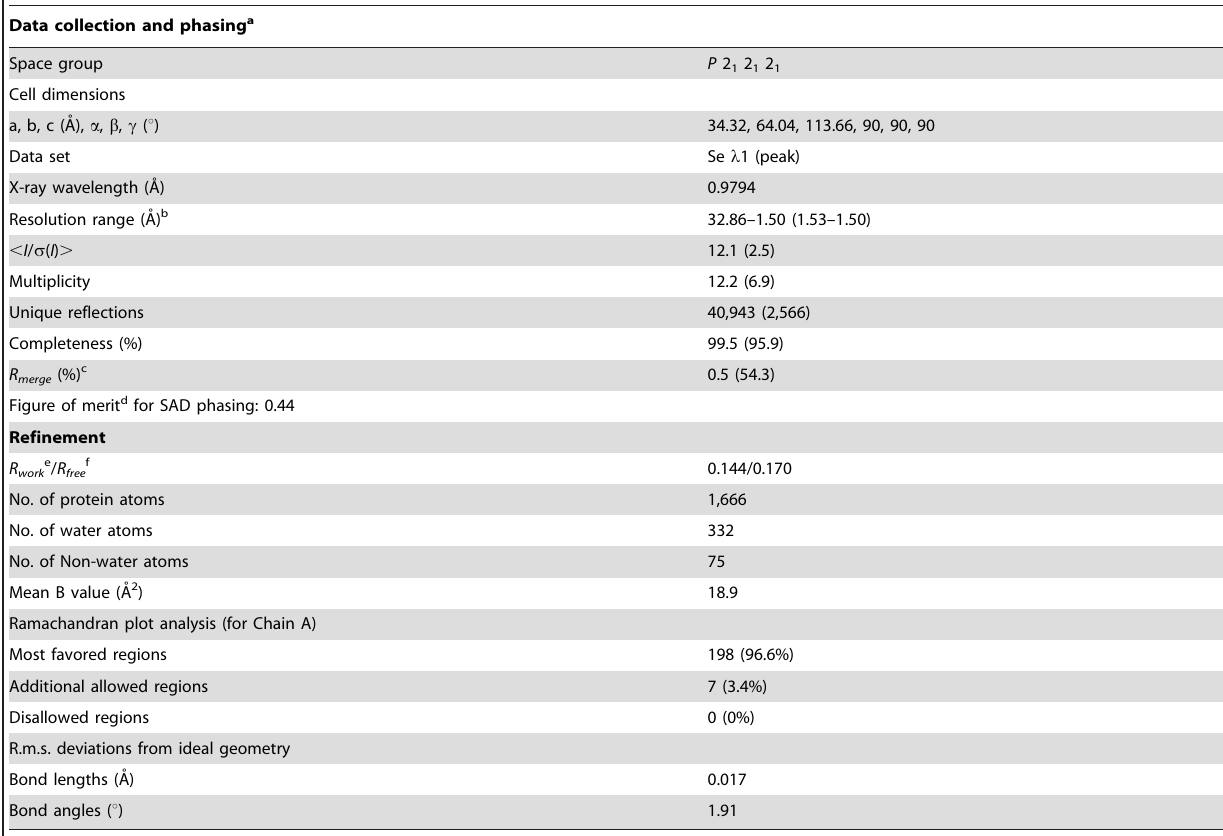
Table 1. Statistics for data collection, phasing, and model refinement.